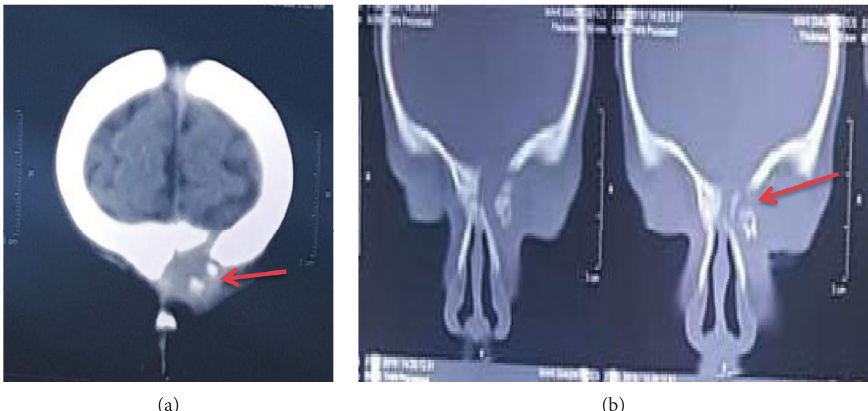
Figure 2: CTscan head of the infant. (a) Defect in the frontal bone; there is discontinuity of the left frontal bone with erosions. (b) Erosion of the frontal bone plate due to chronic postinfective etiology as seen on CT head, suggestive of PPT.